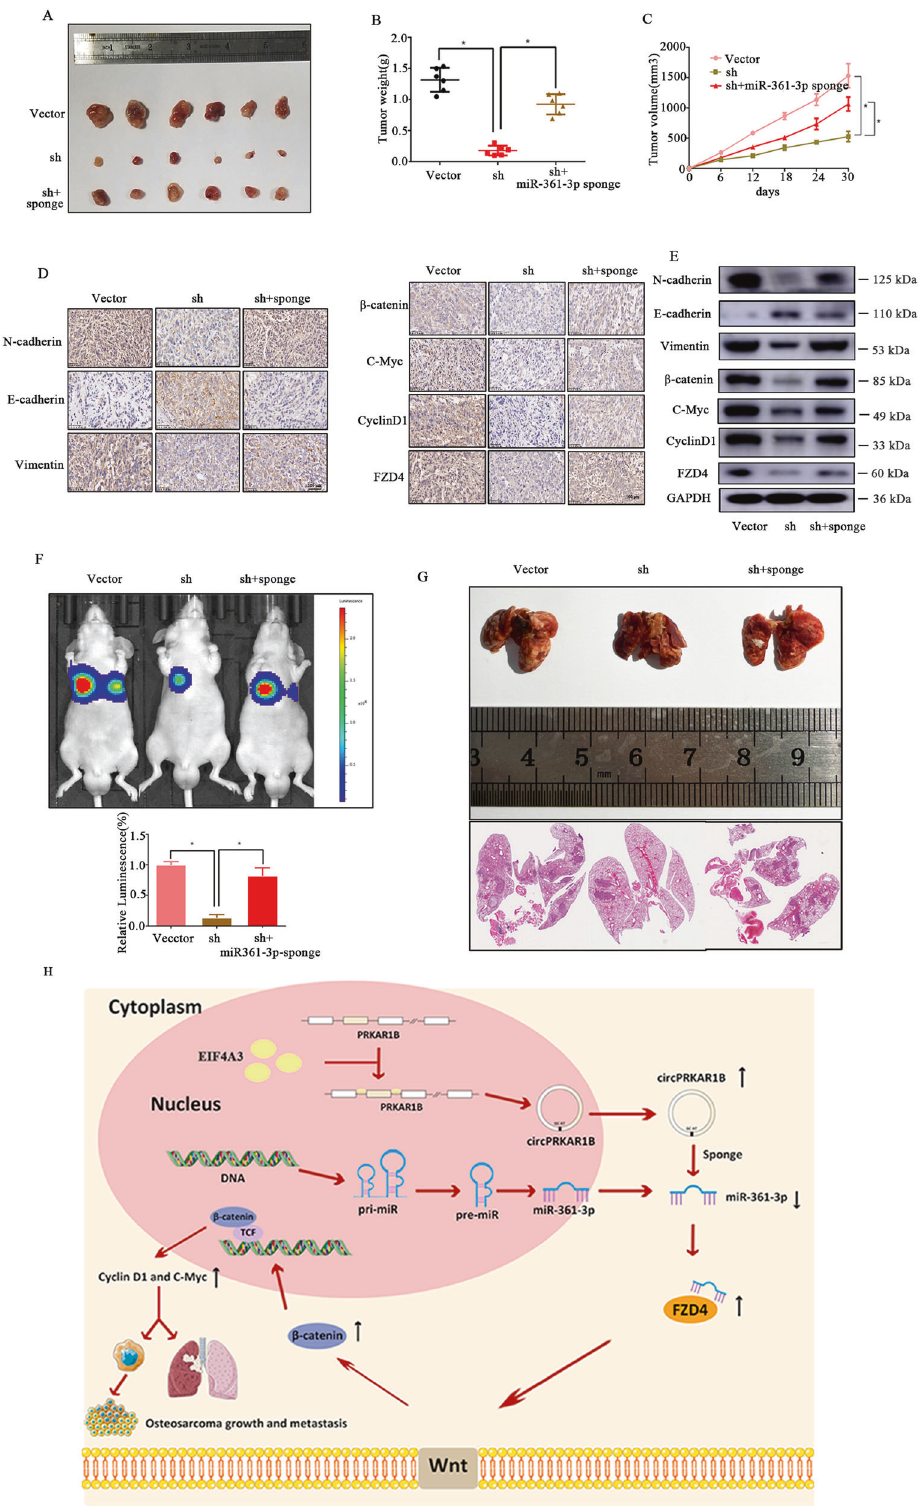
Overexpression of circPRKAR1B suppresses the sensitivity of OS cells to Cisplatin (CDDP) The development of chemotherapeutic drug resistance worsens the prognosis of patients with osteosarcoma, and therefore, it